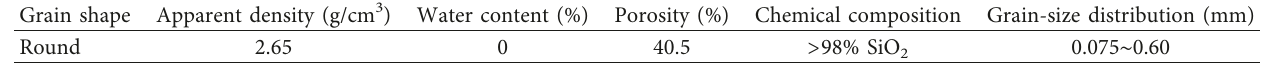
Table 1: Physical properties of the sand used in this study.